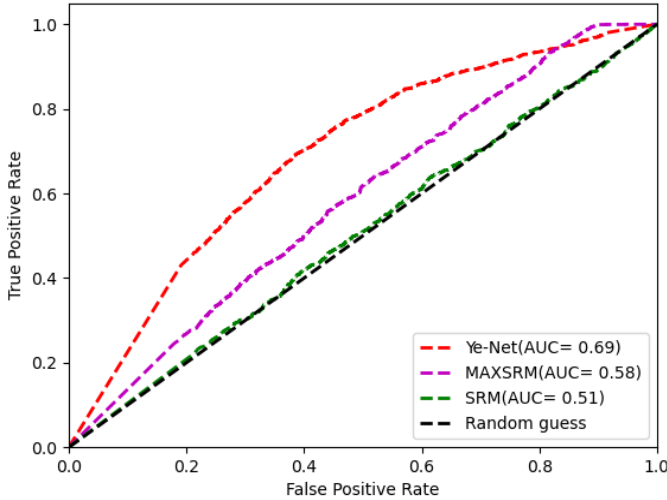
Figure 14. ROC and AUC detected by SRM, maxSRM and Ye-Net steganalysis algorithms.